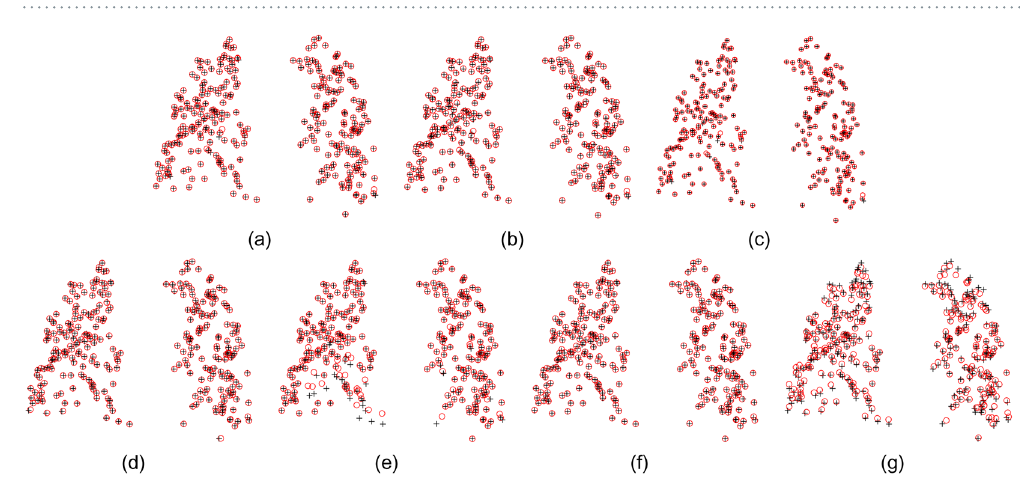
Figure 7. Performance of non-rigid point set registration algorithms on the point set extracted from 4D CT, which is shown in Fig. 6(a). ( a ) DSMM, ( b ) PR-GLS, ( c ) pSMM, ( d ) GMM-L2, ( e ) CPD, ( f) RBF-RPM, ( g ) TPS- RPM.